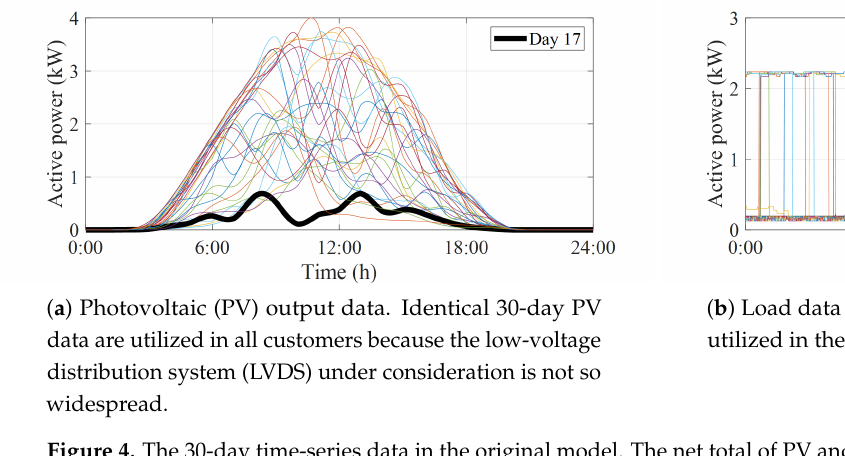
Figure 4. The 30-day time-series data in the original model. The net total of PV and load data at each bus corresponds to the passive part of active power P p n .